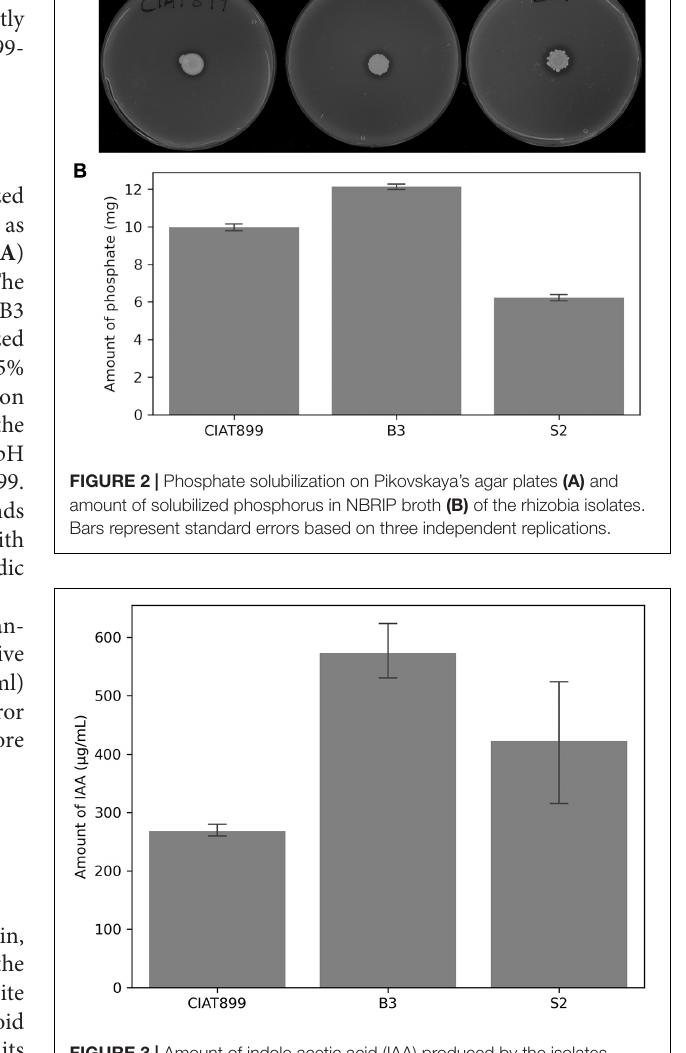
FIGURE 3 | Amount of indole acetic acid (IAA) produced by the isolates CIAT899, B3, and S2 in the liquid media and measured by calorimetric